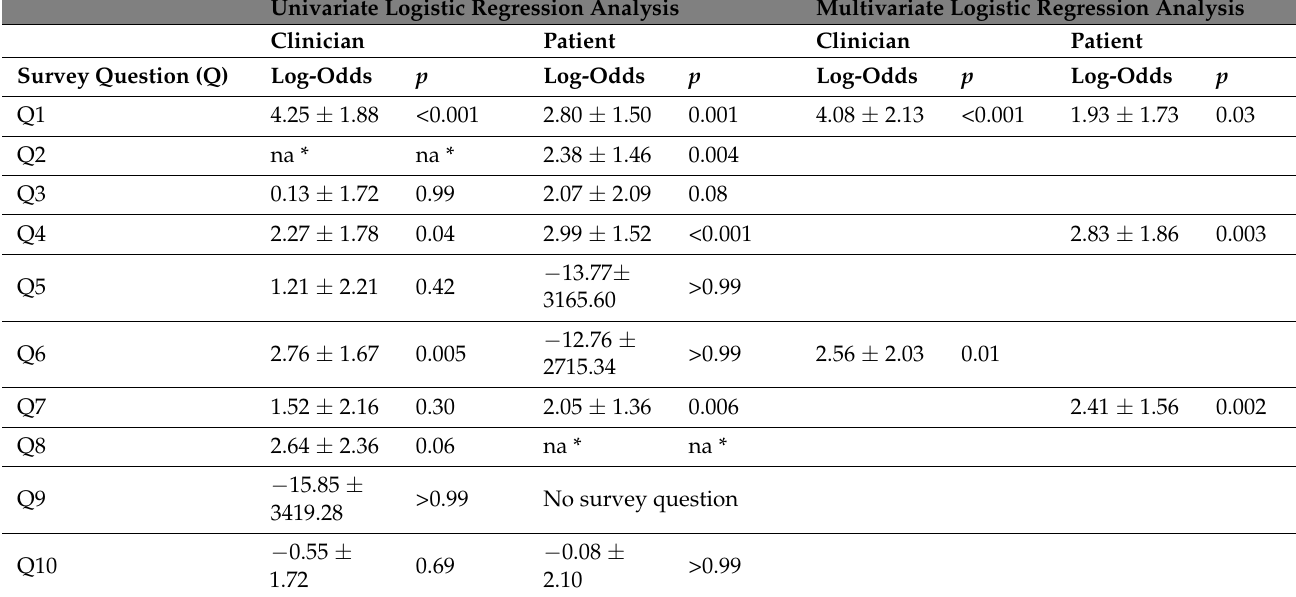
Table 4. Predictors of clinician and patient